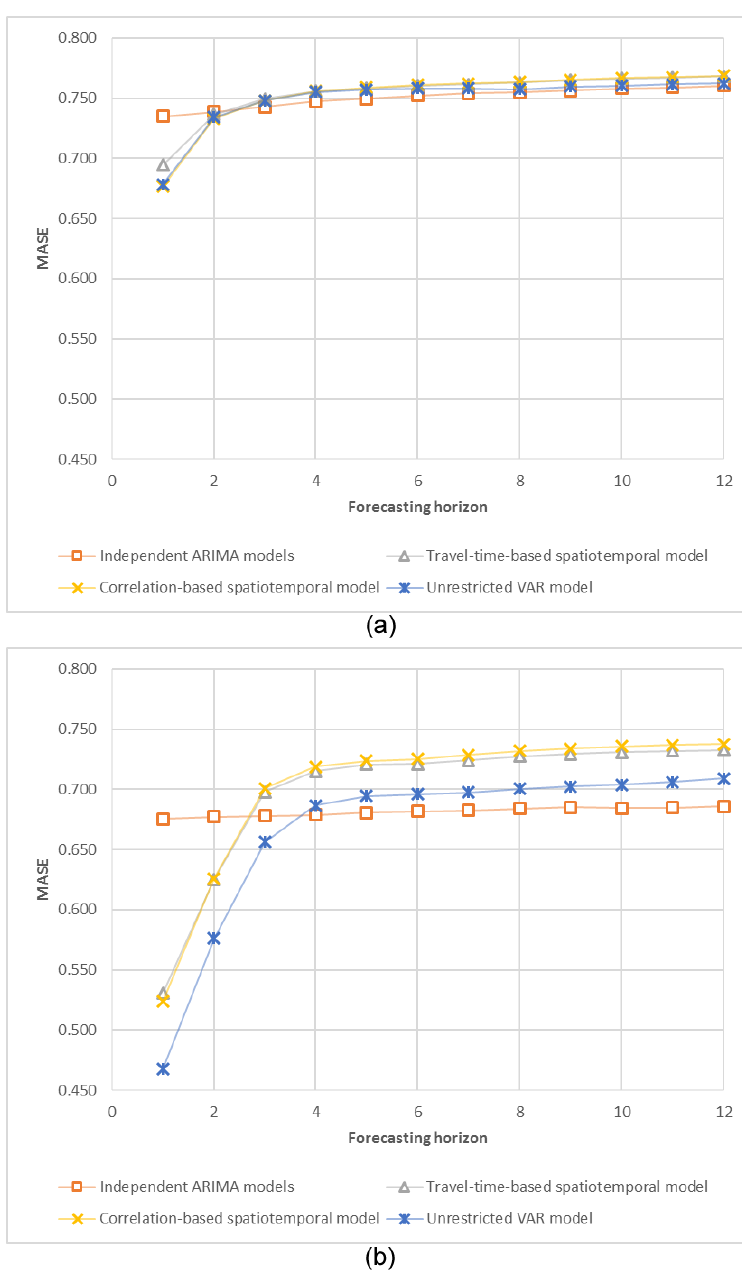
Figure 5. MASE values for different forecasting horizons: ( a ) detrended traffic volume, the complex spatial structure, ( b ) detrended traffic volume, the sequential spatial structure.